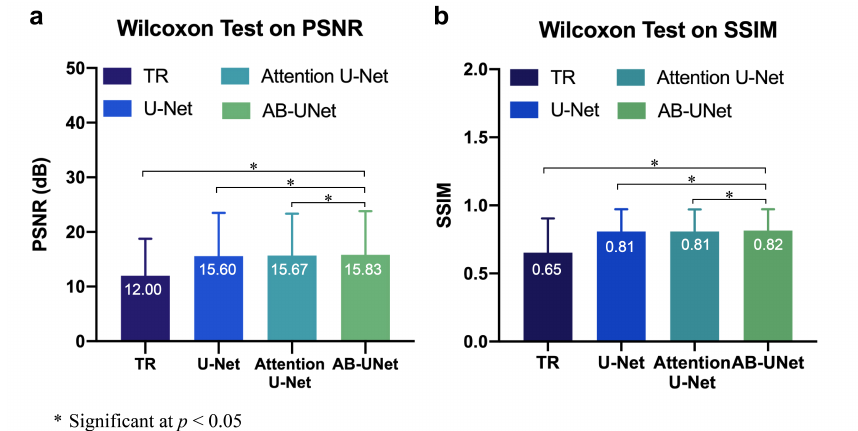
Figure 7. Wilcoxon test on ( a ) PSNR and ( b ) SSIM of four methods for test set. The mean value of each data is represented by the height of the bar. The error bar indicates the range of